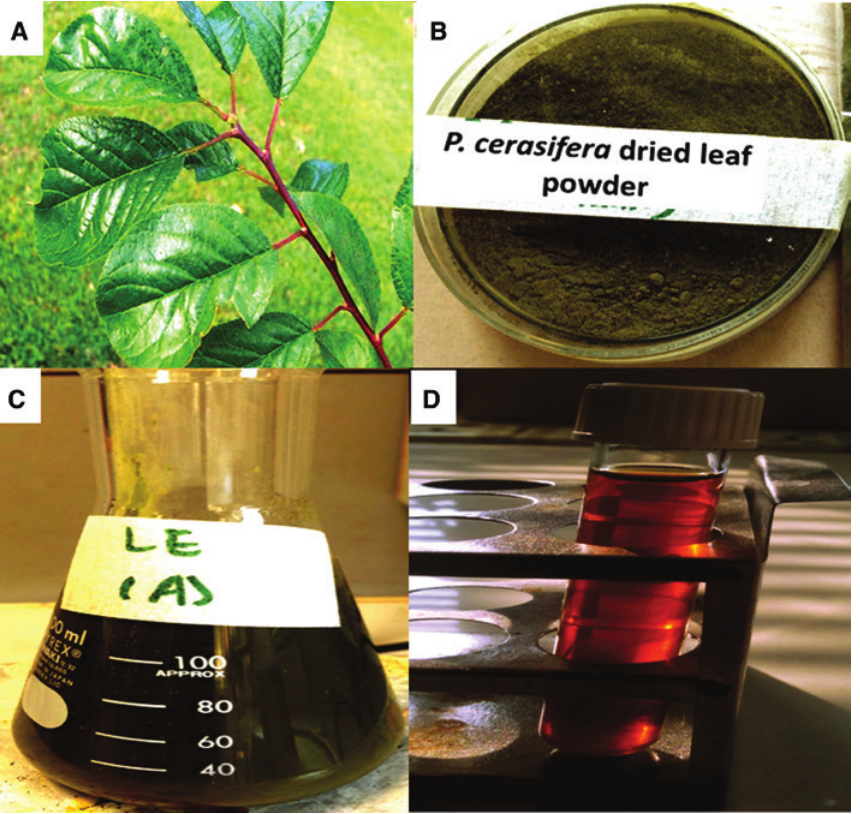
Figure 1: Prunus cerasifera leaves: (A) tree, (B) leaf powder, (C) leaf extract in deionized water, and (D) filtered leaf extract used as a reductant in foliar doped nanoparticles